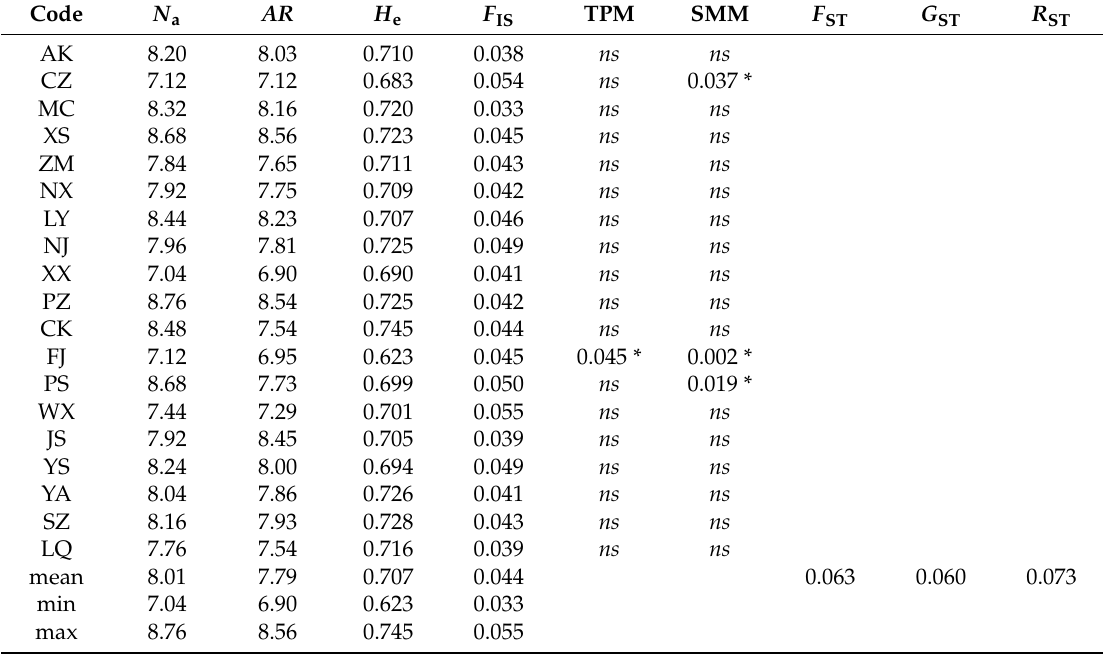
Table 3. Mean values of genetic diversity statistics for 25 microsatellite loci in 19 Q. variabilis populations.